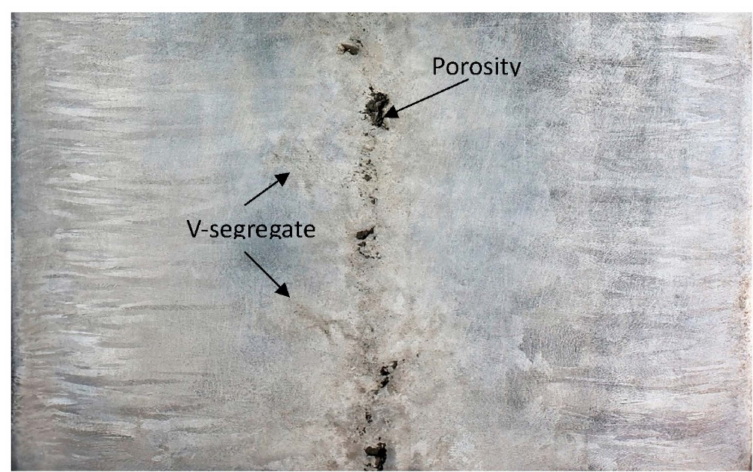
Figure 2. Macroetched longitudinal section of billet sample.